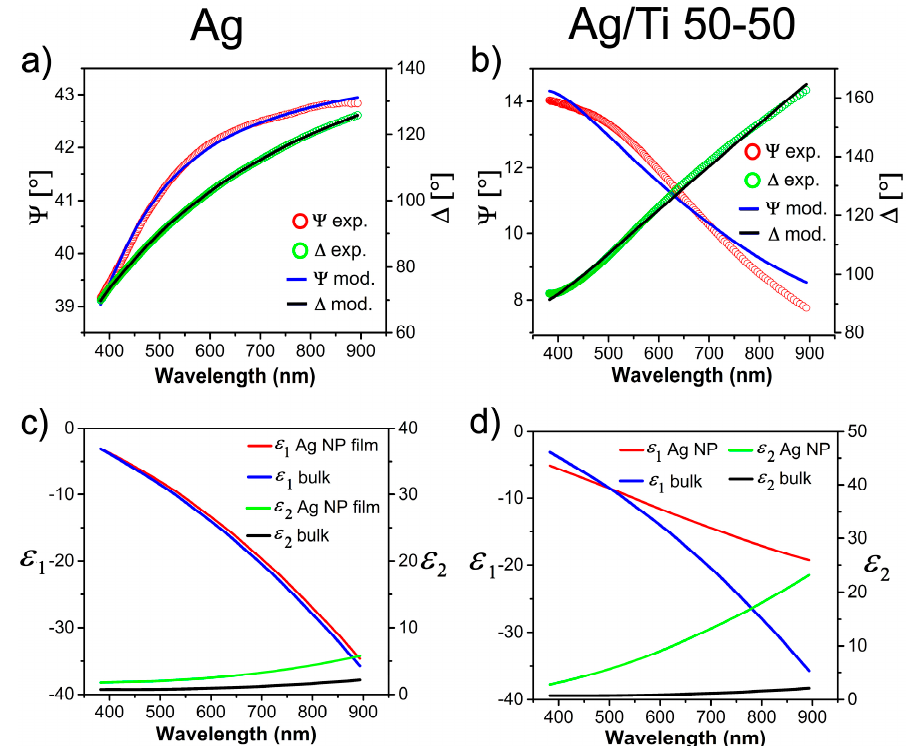
Figure 4. ( a ) Spectroscopic ellipsometry data and fit of Ag NP film with the model proposed in the main text; ( b ) Spectroscopic ellipsometry data and fit of Ag NP/TiO 2 (Ag/Ti 50-50) film with the